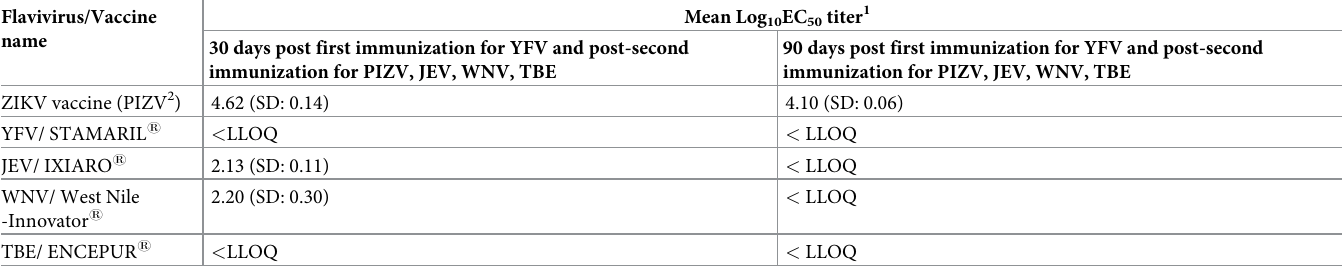
Table 5. Titer in Z-RVP-384 assay of non-human primate sera post-immunization with five different flavivirus vaccines. Flavivirus/Vaccine